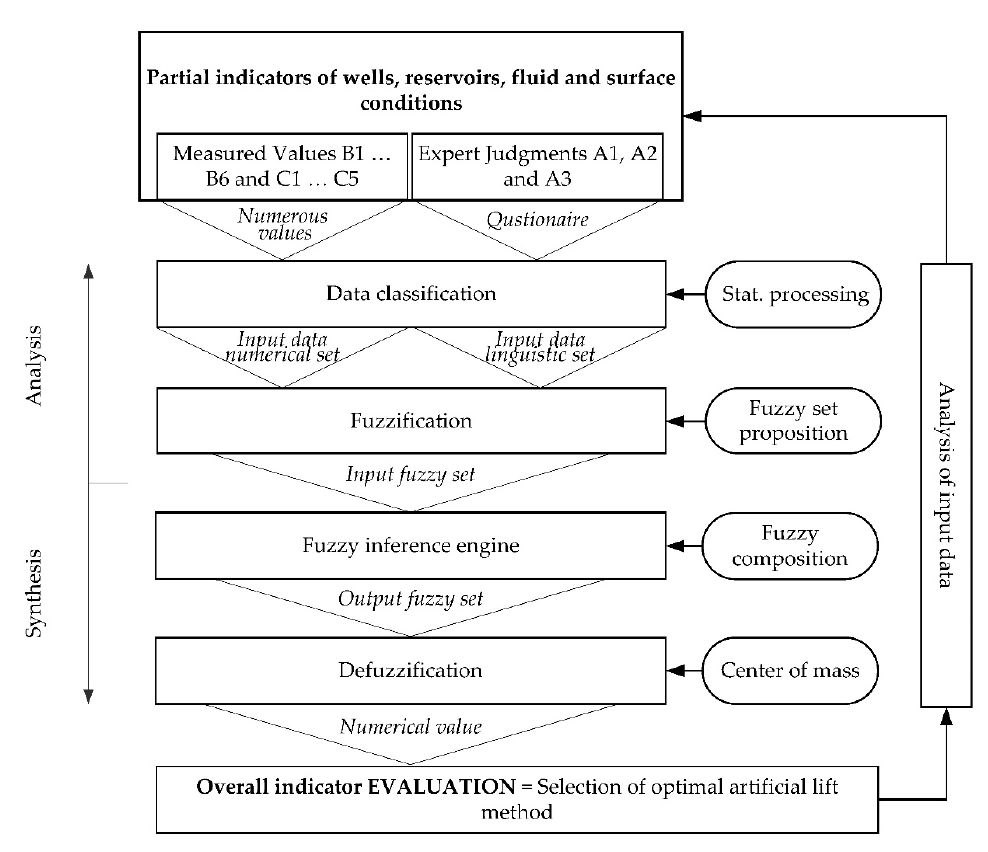
Figure 1. The schematic diagram of the fuzzy model.